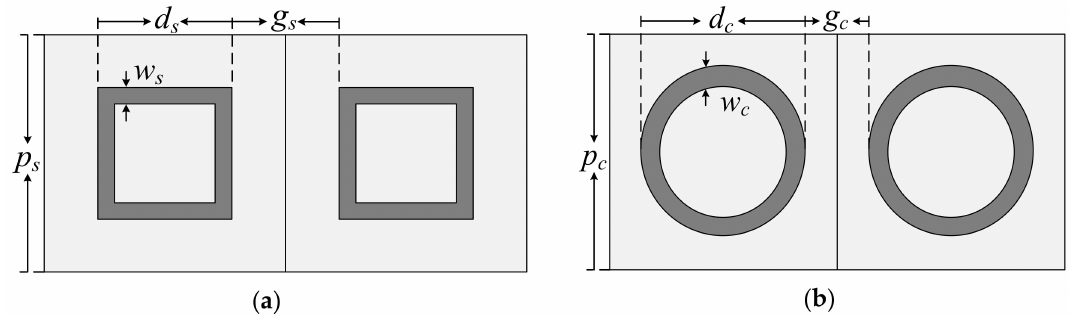
Figure 2. Dimension parameters: ( a ) Square-loop structure, ( b ) Circular-loop structure.